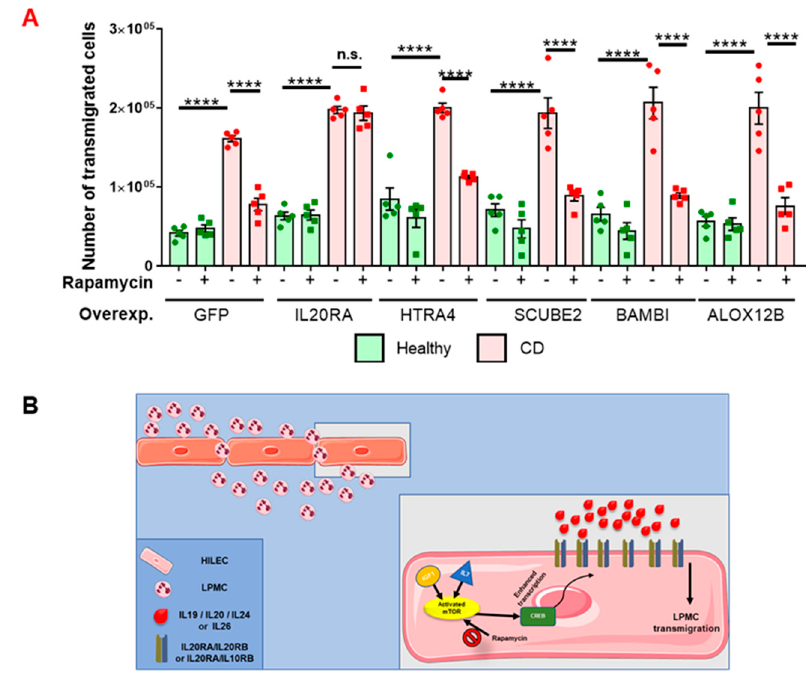
Figure 4. mTOR-dependent IL20RA signaling regulates LPMC transmigration across CD HILECs. ( A ) Scatter plots with bars showing the number of transmigrated LPMCs at the indicated conditions. N = 5/group. Data are represented as mean ± s.e.m. **** p ≤ 0.0001, n.s.: not significant. ( B ) Cartoon showing the working model overseeing LPMC transmigration across the lymphatic barrier in patients with